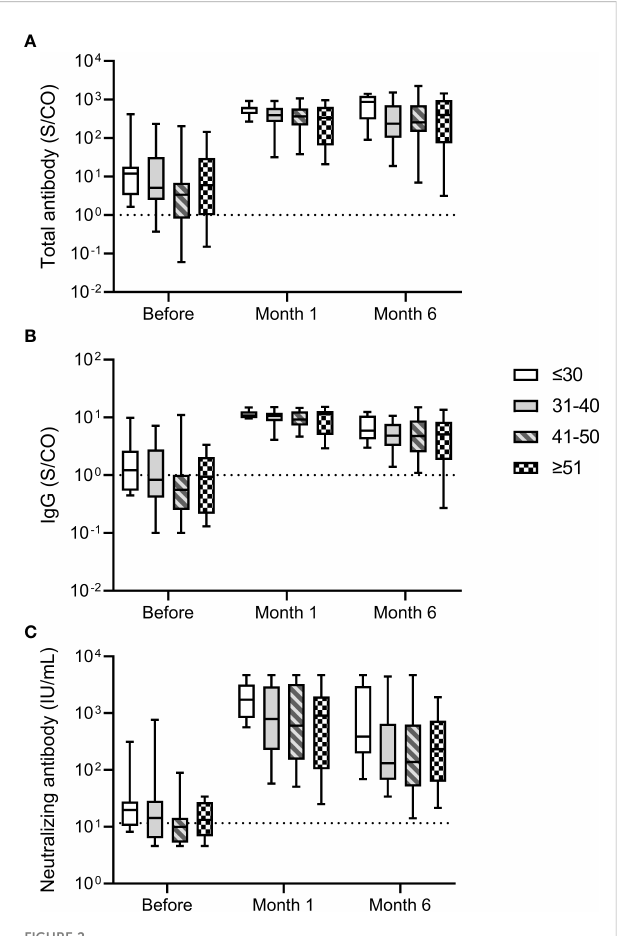
FIGURE 2 Antibody response induced by the third dose of homologous BBIBP- CorV inactivated vaccine in participants of different ages. The levels of total antibody (A) and IgG antibody (B) against the receptor binding domain (RBD) of the SARS-CoV-2 spike (S) protein and neutralizing antibody (C) against SARS-CoV-2 after the third dose are shown as the range (whiskers), interquartile range (boxes) and median (line within the boxes) values. The dashed lines represent the cut-off for total antibody and IgG antibody against the RBD of the SARS-CoV-2 S protein and neutralizing antibody against SARS-CoV-2. Comparisons were done by Kruskal-Wallis test.